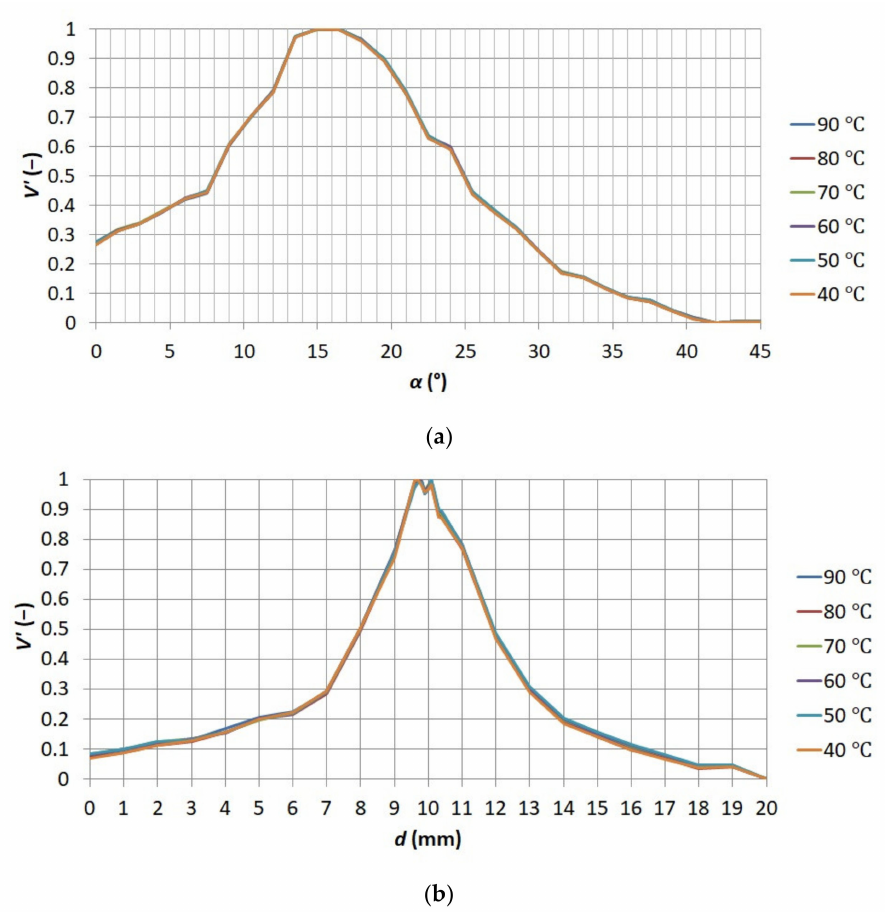
Figure 10. Relationships ( a ) between standardized sharpness measure V (cid:48) and adjustment ring angle α placed on the thermographic camera lens for various temperatures of the sensor ( b ) between standardized sharpness measure V’ and distance d between thermographic camera lens and observed object for various temperatures of the sensor.